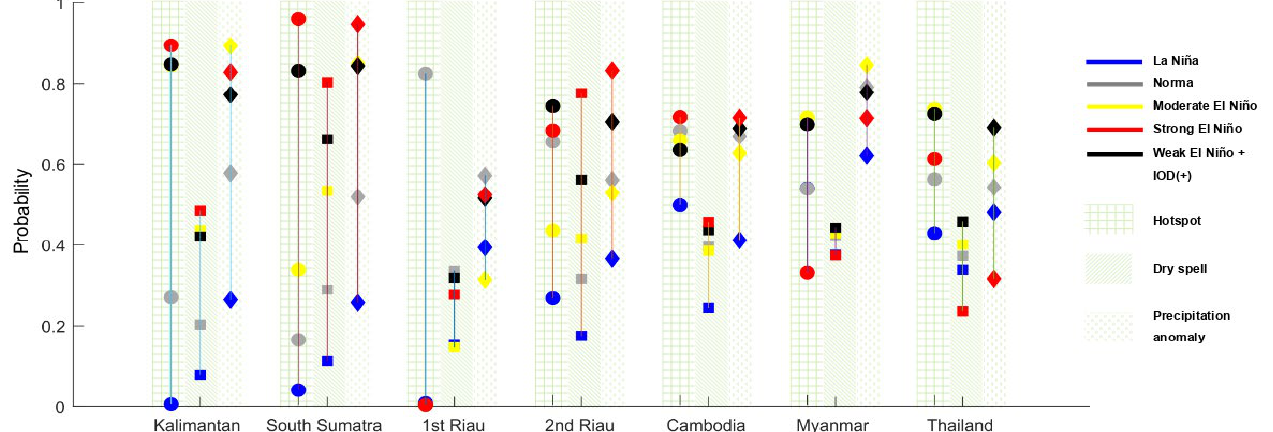
Figure 10. Probabilities graph where each variable is more than the average value in each category for the year and region being analyzed. for the year and region being